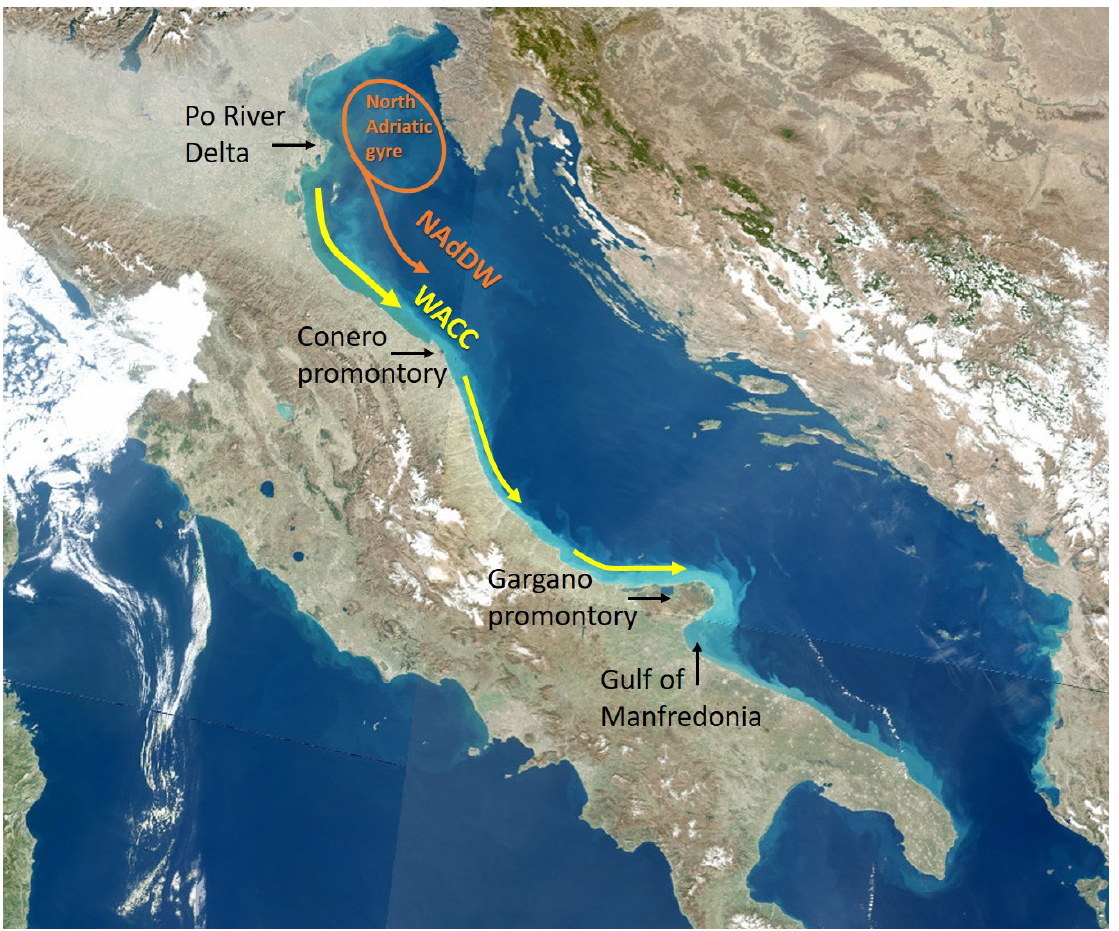
Figure 1. True Colour (bands 9,6,4) image of the Adriatic Sea, 28 February 2019, by the OLCI sensors on board of the Sentinel-3A and Sentinel-3B spacecrafts. The Western Adriatic Coastal Current (yellow arrows) is clearly visible, due to its suspended sediment load, transported along the coast [13]. The North Adriatic Gyre and the subsequent path of the North Adriatic Dense Water are highlighted in orange [13]. The black arrows indicate the geographic locations mentioned in the